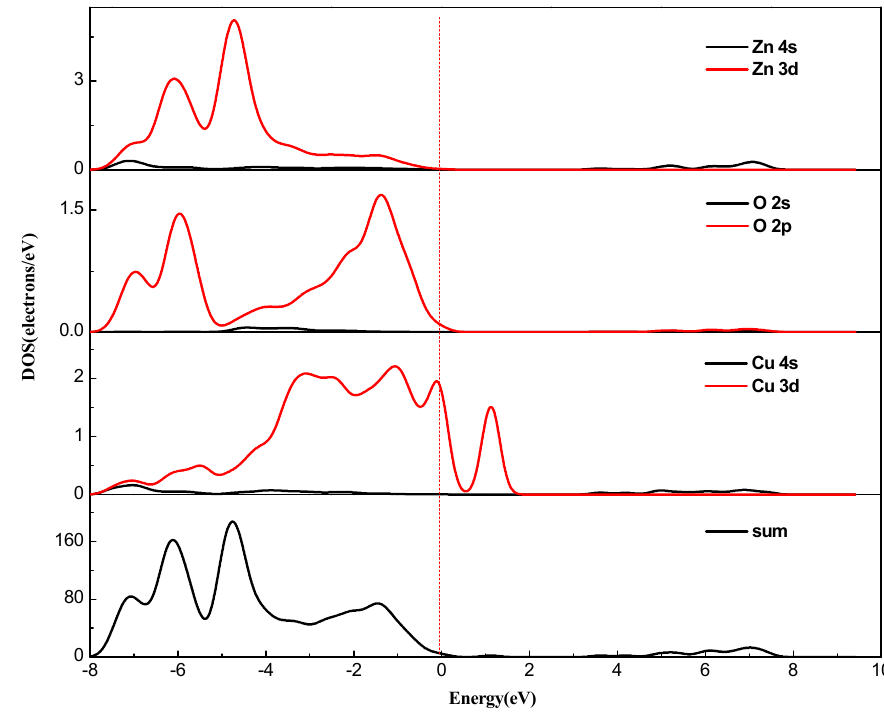
Figure 6. PDOS of Cu 0.0278 Zn 0.9722 O.